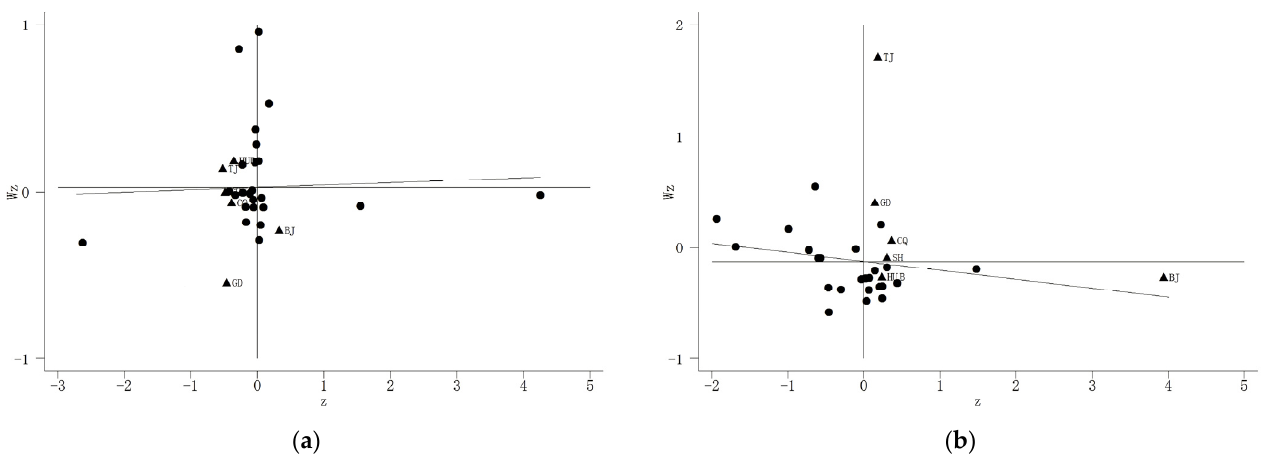
Figure 8. Moran scatterplots for the Evolution_Eco indicator. ( a ) Differences between the CETS implementation process and before implementation; ( b ) differences between the CETS post-implementation and implementation process.